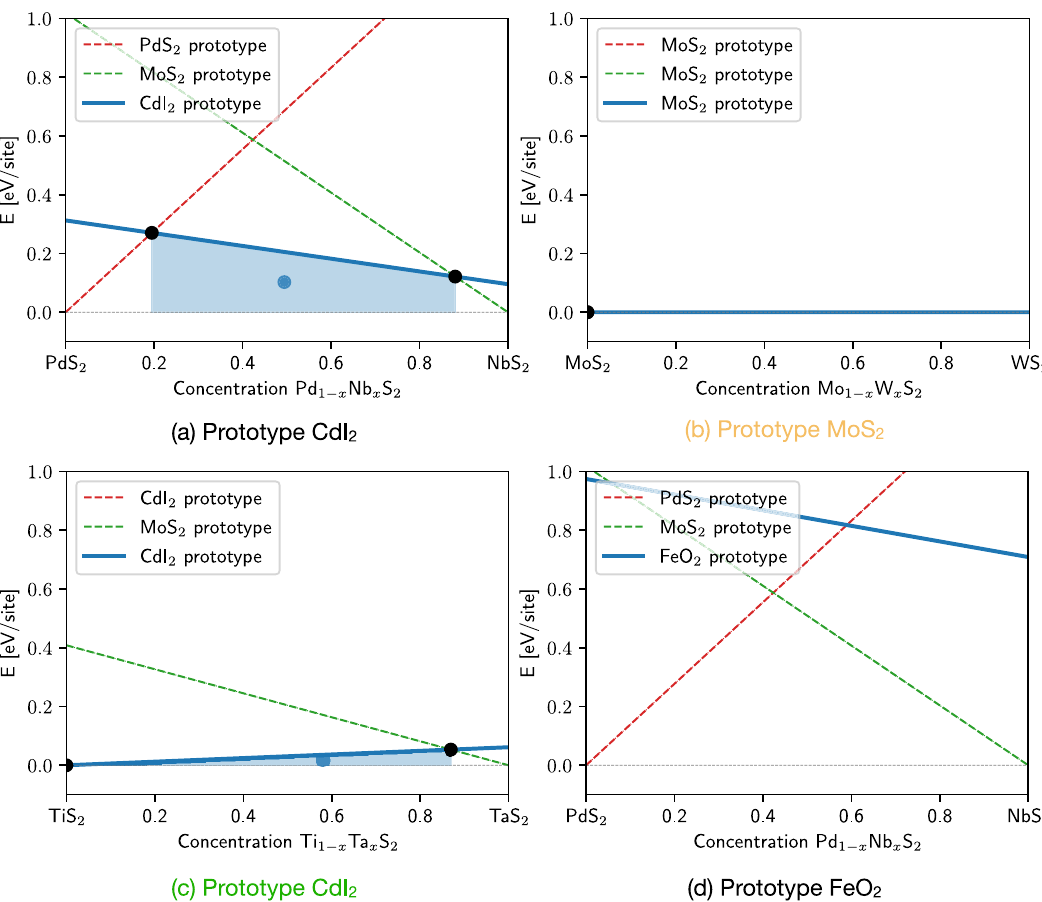
Fig. 3 Examples of metastability metric. Metastability metric construction (blue lines) for a (Pd:Nb)S 2 in CdI 2 prototype ( b ) (Mo:W)S 2 in MoS 2 prototype, c (Ti:Ta)S 2 in CdI 2 prototype, and d (Pd:Nb)S 2 in FeO 2 prototype. Blue-shaded areas highlight the extent of the metastability window in the energy above the ground state — concentration ( x , E ) space. Blue circles mark the centroids of the area below the solid solution energy within the metastability window. Red dashed lines show the energy in the prototype of the left end-member, x = 0. Green dashed lines show the energy in the prototype of the right end-member, x = 1. When the considered prototype (blue line) coincides with one of the GS prototype, the line relative to the latter is hidden. The colour of the title matches the entry highlighted in the matrix in Fig.